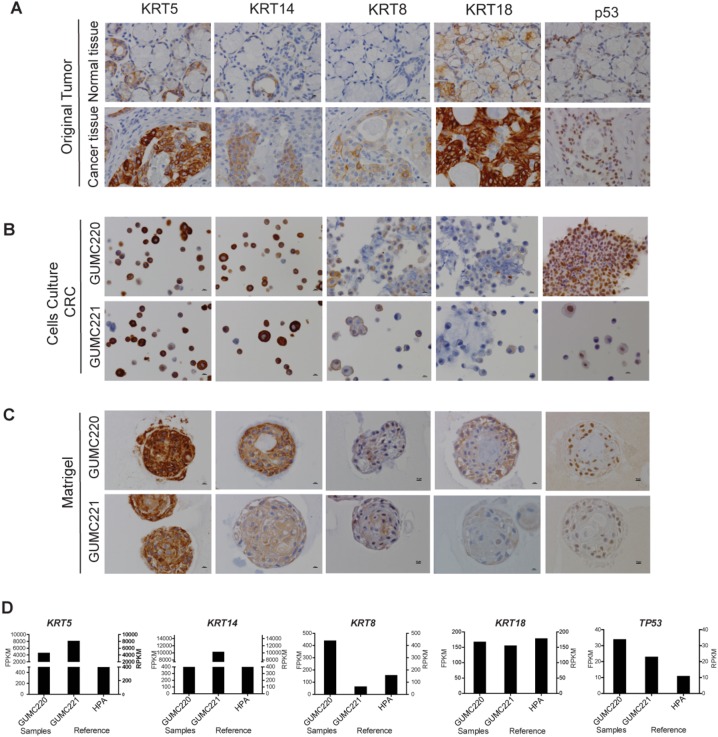
Evaluation of KRT5, KRT14, KRT8, KRT18 and p53 in original tumor and GUMC220/221 CRC and Matrigel cultures. (A-C) Representative IHC images for KRT5, KRT14, KRT8, KRT18 and p53 in adjacent normal tissue (top) and MEC (cancer tissue, bottom) (A), GUMC220 (top) and GUMC221 (bottom) cell pellets from CRC cultures (B), and GUMC220 (top) and GUMC221 (bottom) Matrigel spheroids (C). Images were taken at 40× magnification. Scale bars: 10 μm. (D) Left y-axis: relative FPKM values for KRT5, KRT14, KRT18 and Tp53 in GUMC220 and GUMC221. Right y-axis: for reference, relative RPKM reads for KRT5, KRT14, KRT18 and Tp53 from the HPA for normal salivary gland tissue.